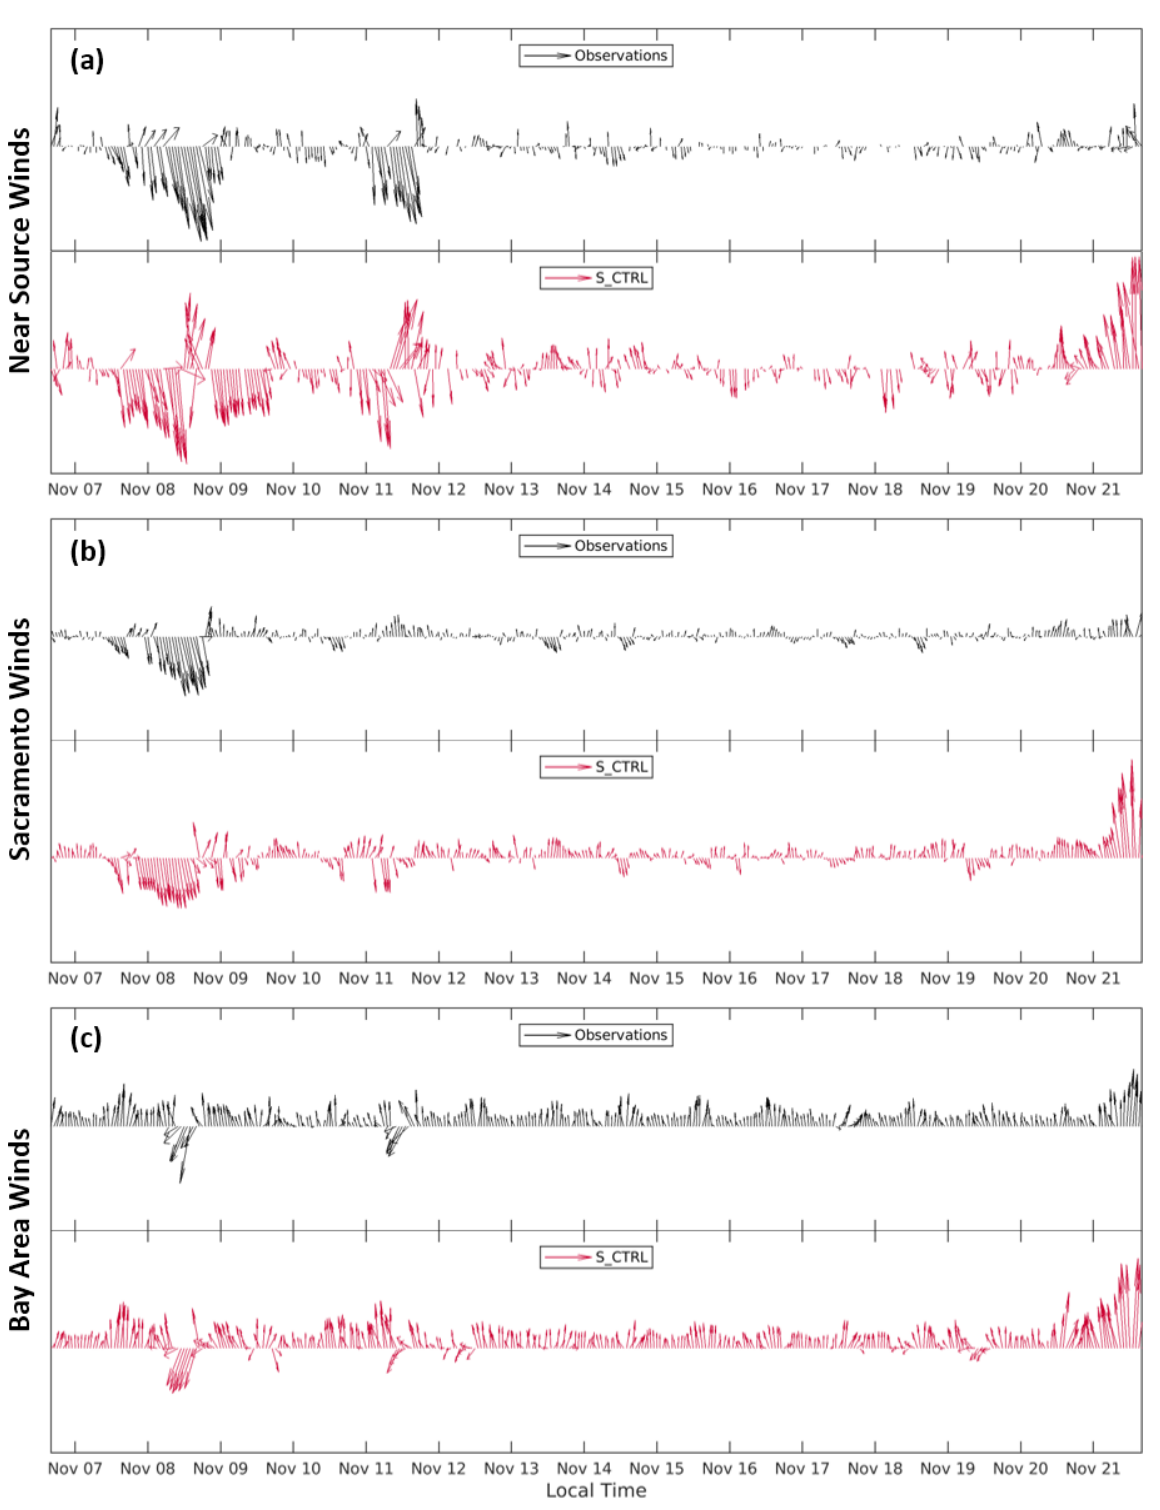
Figure 4. Comparison of AQS and NCDC wind observations (black) with S_CTRL predictions (red) averaged over the three areas of study: (a) near the wildfire ( N = 4), (b) Sacramento ( N = 6), and (c) the Bay Area ( N = 12). Arrows indicate the wind direction and their length represents wind speed. For reference, S_CTRL predicts maximum wind speeds of 8.7, 7.5, and 7.1ms − 1 near the source, in Sacramento, and in the Bay Area, respectively. Paradise and the Sacramento areas experienced strong northerly winds during the first few days of the fire. S_CTRL generally predicted faster and more variable winds, but broader trends in Sacramento and the Bay Area were represented well.